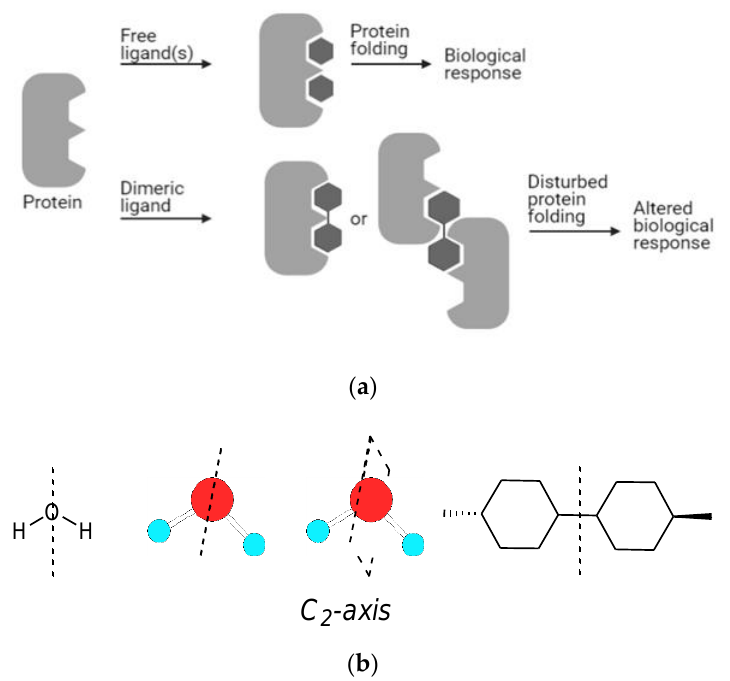
Figure 1. ( a ) Schematic representation of a dimeric molecule interacting with its receptor and biological outcome. ( b ) Schematic representations of C2 -sigma plane or C2 -axis symmetry using small molecules.